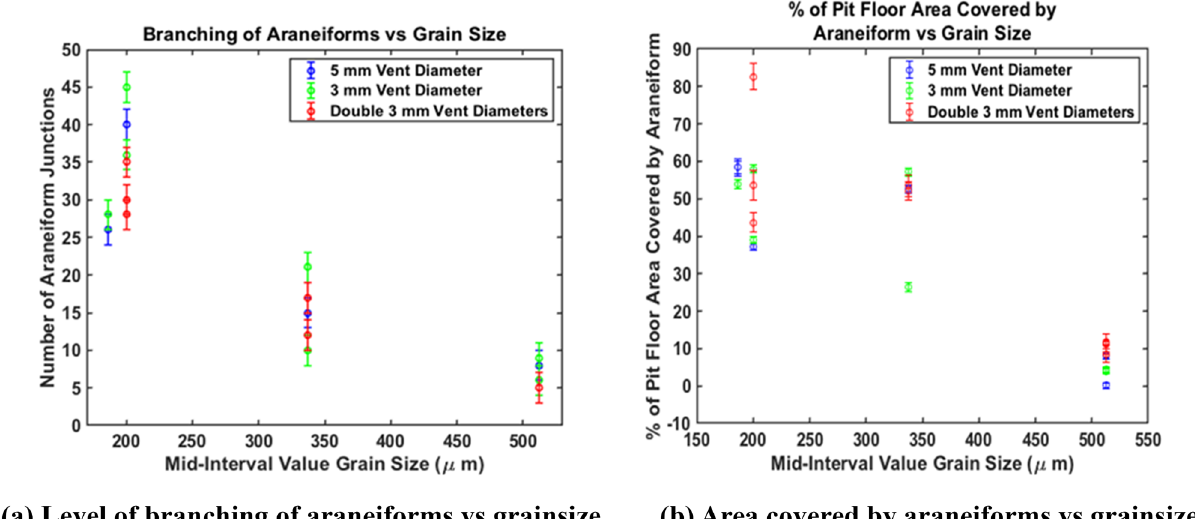
Figure 3. Araneiform morphometry. ( a ) Shows a decrease in the level of branching with grain size. Level of branching varies for finer grain sizes while for coarser grains of 450–600 µ m, is consistent. ( b ) Shows a decrease in area covered by araneiforms with grain